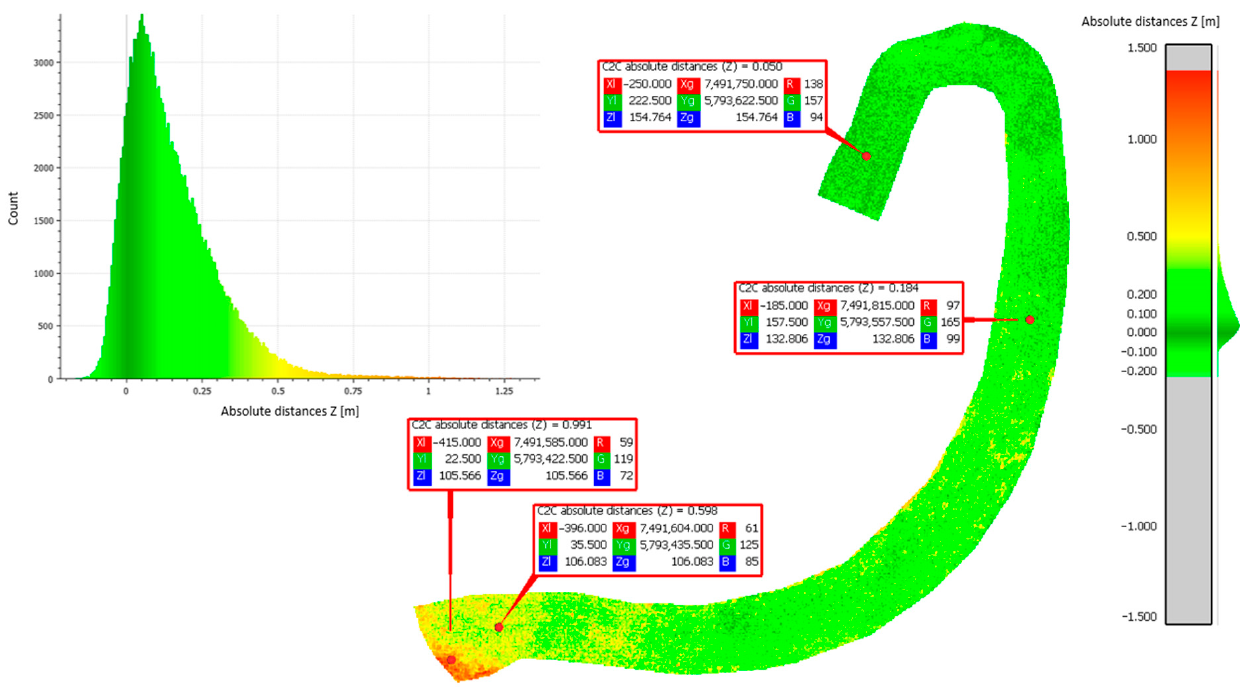
Sensors 2023 , 23 , x FOR PEER REVIEW 12 of 17 Figure 6. C2C distance analyses for set 1 compared to set 2. Figure 6. C2C distance analyses for set 1 compared to set 2.